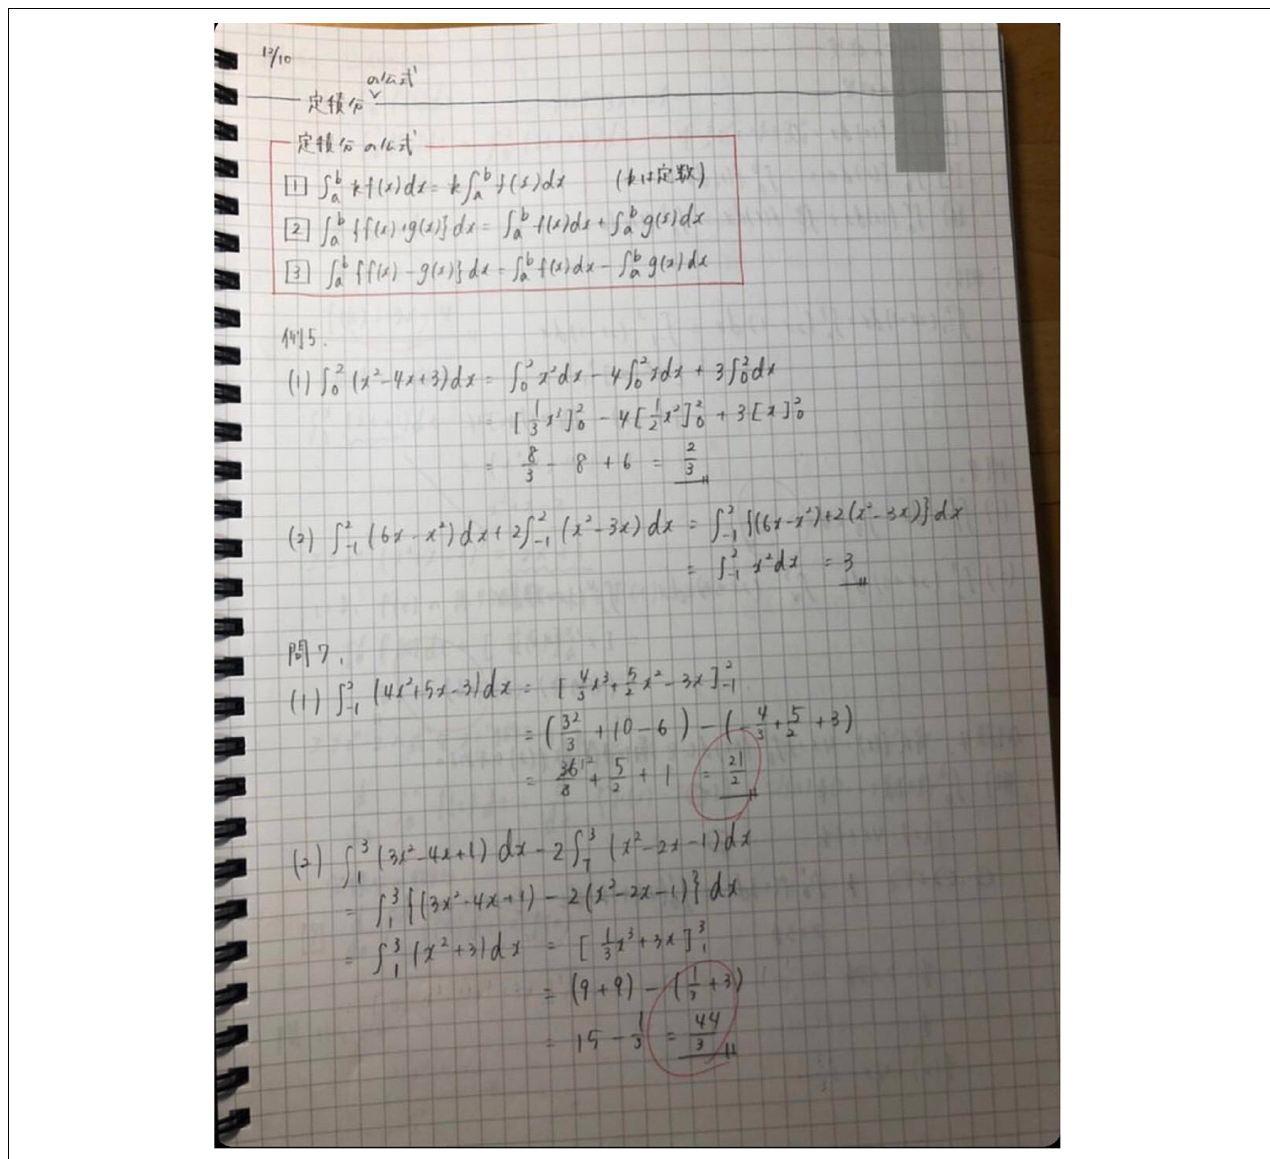
FIGURE 1 | Lecture notes in the Japanese